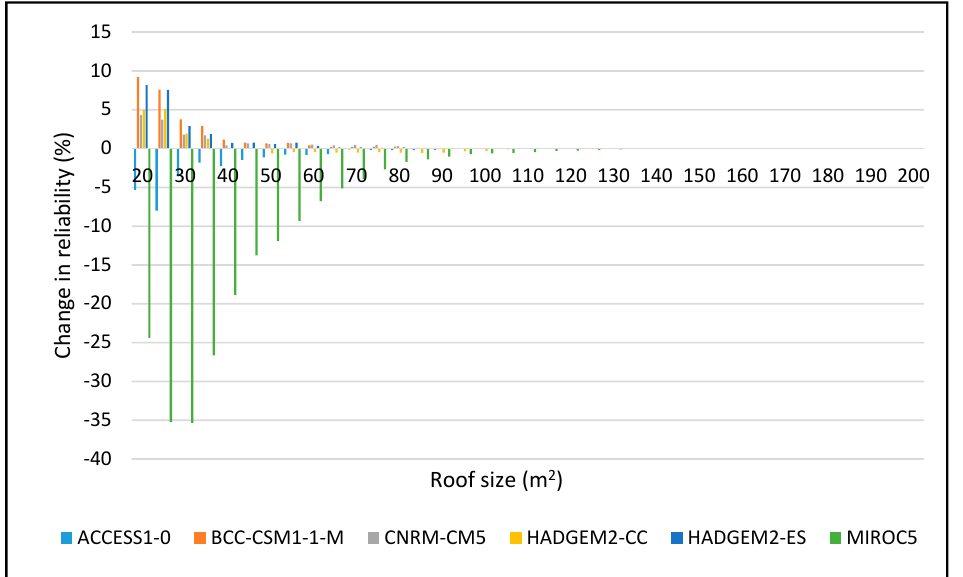
Figure 25. Change in reliability for MAM 2025–2055 period for 5 m 3 tank size. Table 4. Roof sizes required to achieve 80% reliability during MAM season (2025–2055).